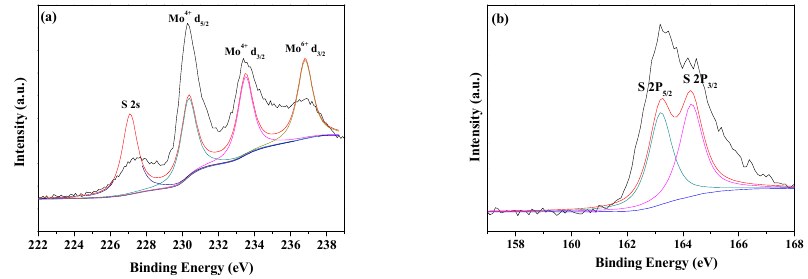
Figure 2. The XPS spectra of ( a ) the Mo 3d; and ( b ) the S 2p.